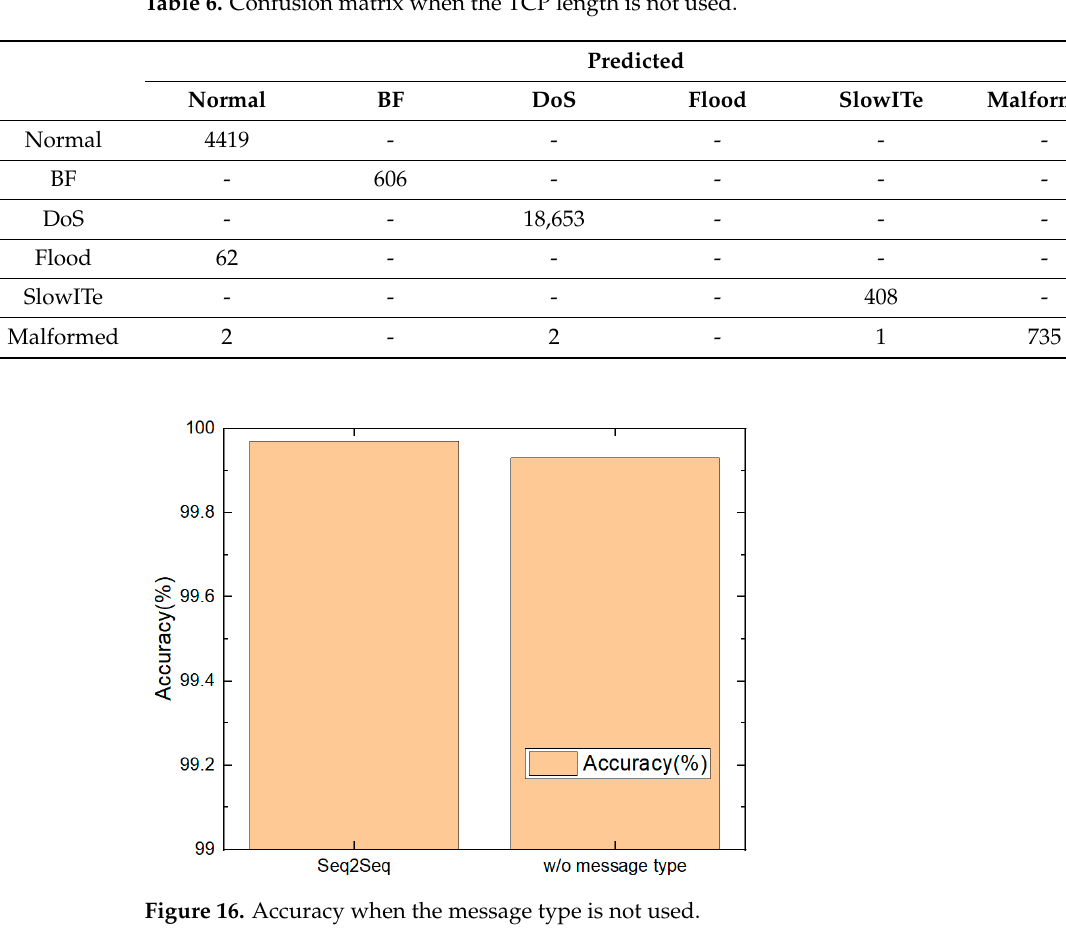
Table 6. Confusion matrix when the TCP length is not used.